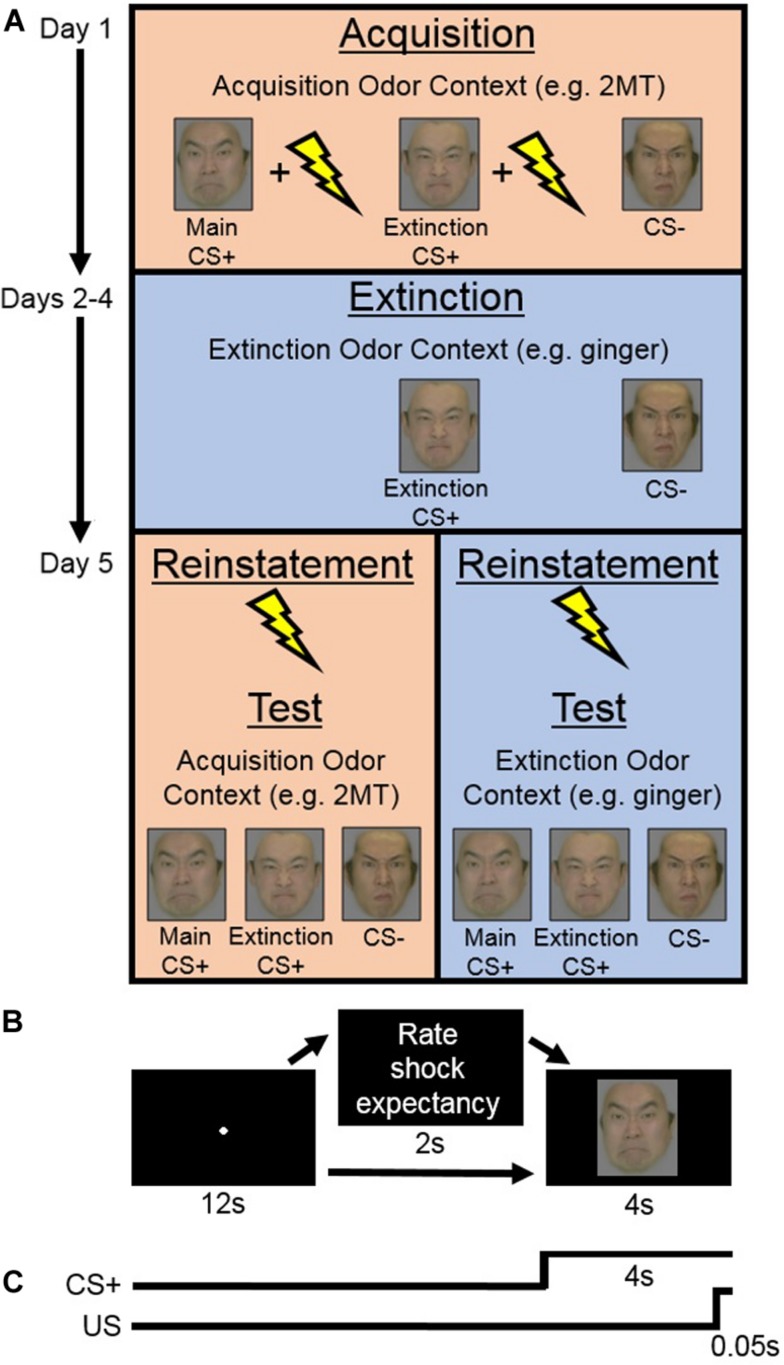
(A) Experimental design of the main experiment. On Day 1 (Acquisition phase), in her Acquisition Odor Context [2-methyl-2-thiazoline (2MT) or control odor], each participant learned to associate both conditioned stimuli (CS)+ s, but not the CS−, with the unconditioned stimuli (US). Next, on Days 2–4 (Extinction phase), in her Extinction Odor Context, each participant was exposed to multiple presentations of the Extinction CS+ and the CS−, with no US presentation. Finally, on Day 5, in the two sessions of the Test phase, each participant was presented with all the CS. Reinstatement with the US was completed at the beginning of each Test session. One of these sessions was completed in the participant’s Acquisition Odor Context and the other in her Extinction Odor Context. This order was counterbalanced between participants. (B) On each trial of the Acquisition and Test phases, participants saw a central fixation point for 12 s. This was followed in some cases by a screen that appeared for 2 s with instructions for participants to rate electric shock (US) expectancy once the CS appeared on screen. Finally, a CS was presented for 4 s. (C) On most CS+ trials during the Acquisition phase, the US was presented during the last 0.05 s of CS+ presentation.